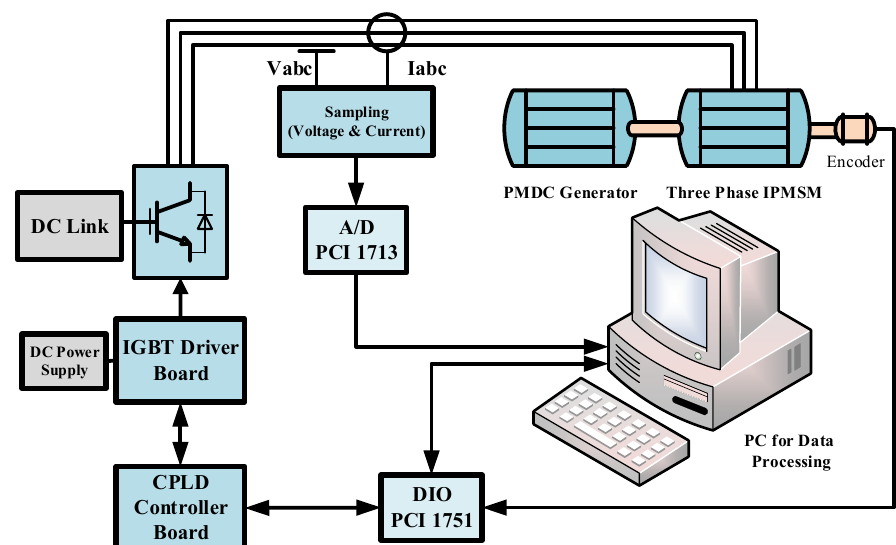
Figure 6. Laboratory implementation block diagram.